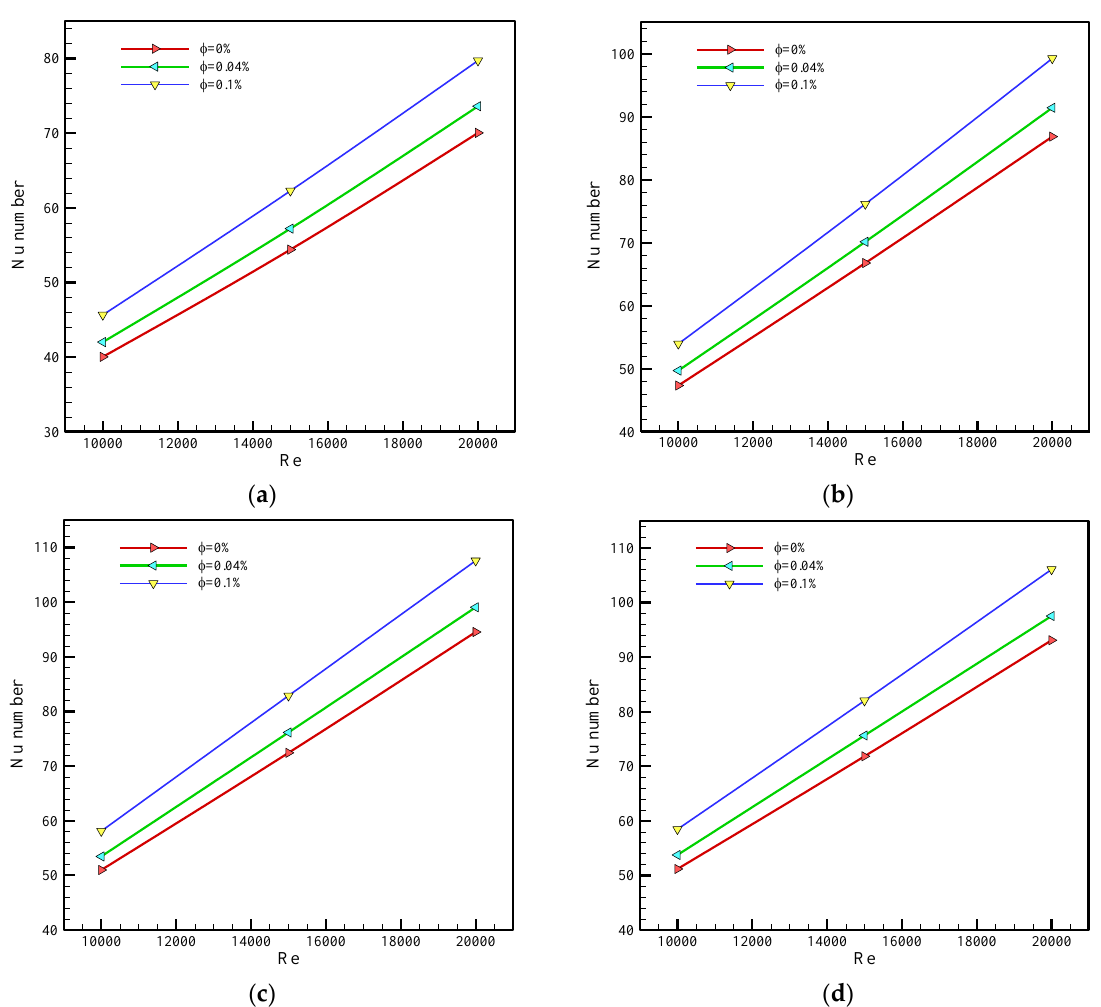
Figure 9. Nusselt number against Reynolds number at various solid volume fractions with baffle angles of ( a ) 45°, ( b ) 90°, ( c ) 135°, and ( d ) 180°.